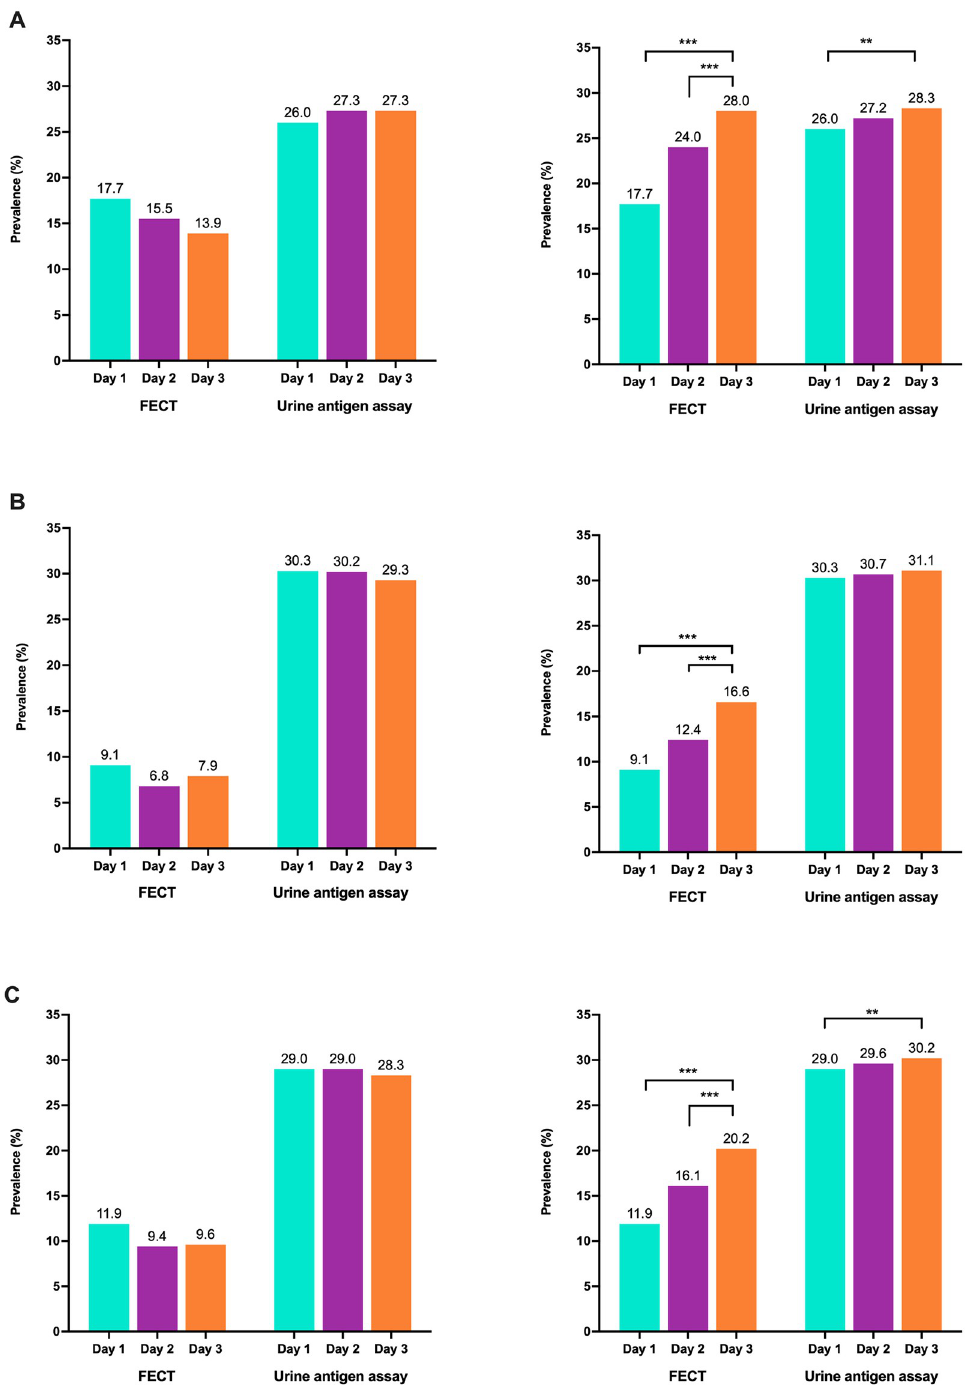
Fig 2. Prevalence of O . viverrini infection determined by FECT and urine assay for three consecutive days. The daily prevalence of opisthorchiasis (left panel) and the cumulative prevalence (right panel) are illustrated according to locality. (A) KKN; Muang District, Khon Kaen Province. (B) KSN; Nong Kung Sri District, Kalasin Province. (C) Both sites combined. McNemar Test, �� P < 0.01, ��� P < 0.001.